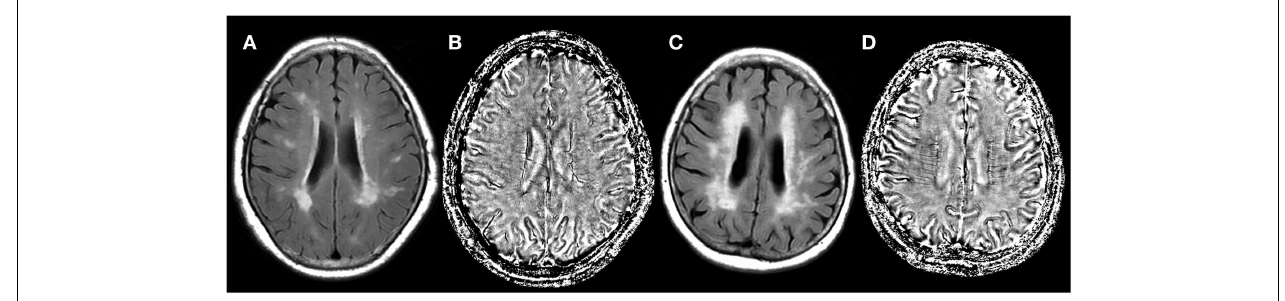
16.88ml (A) . Number of voxels of the deep medullary veins was increased (4897 vs. 2782) in the severeWMH patient (D) , compared with mildWMH patient (B)